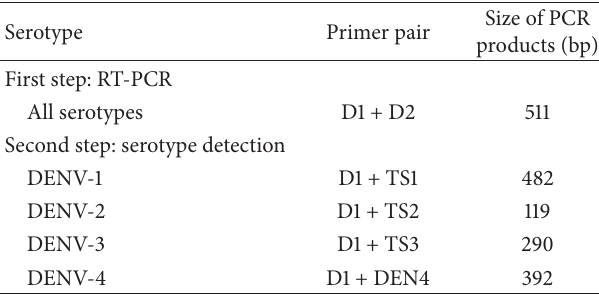
Table 2: Dengue virus specific primers and their expected